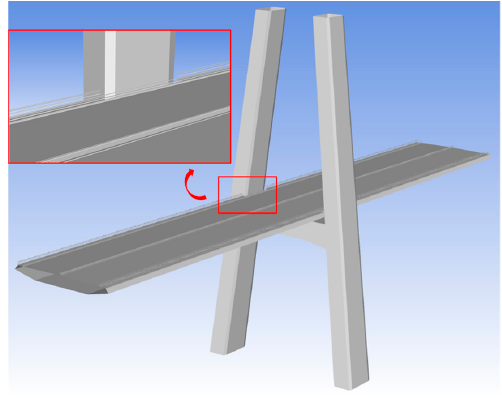
Figure 5. Geometric model. Figure 6. Near wall mesh.